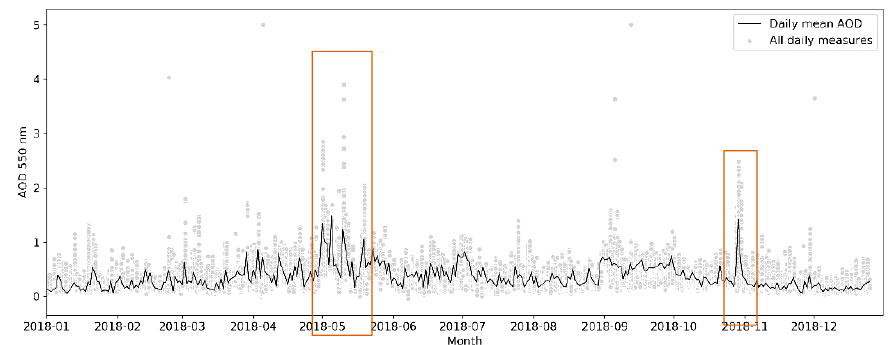
Figure 3. Temporal variations of AOD over Egypt from MODIS. The black line represents the daily mean AOD; the scattered grey points represent all daily measurements of AOD in 2018.